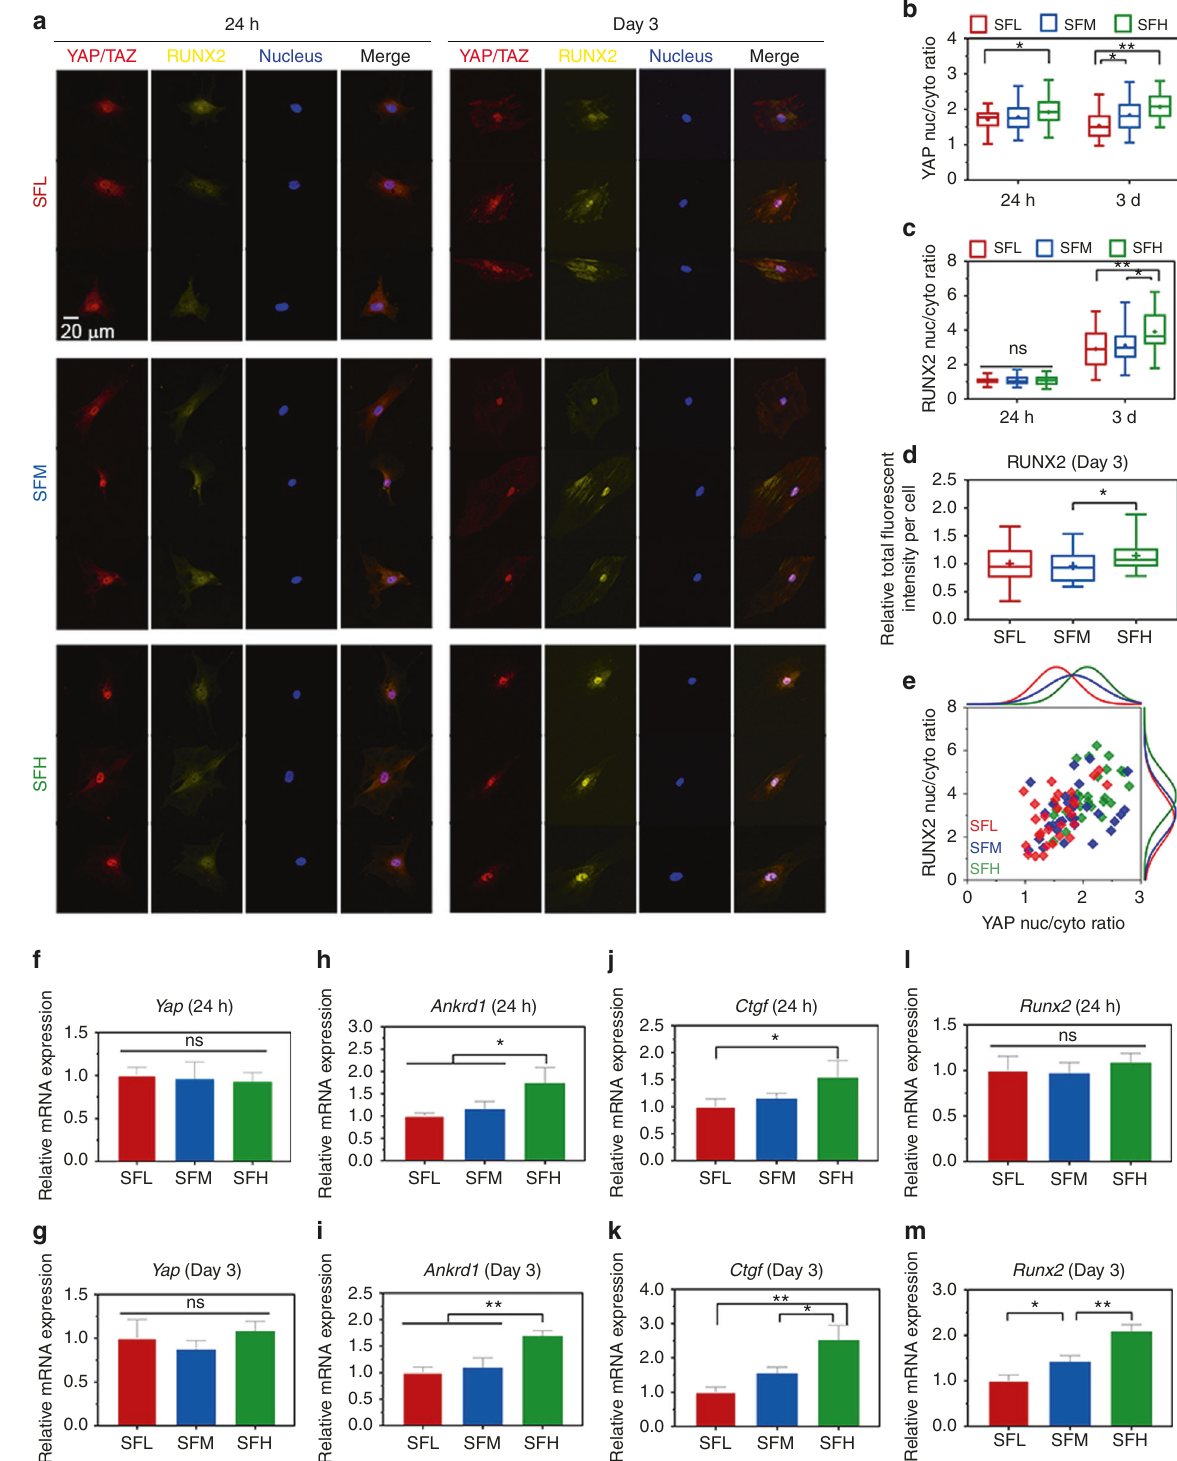
Fig. 5 YAP/TAZ and RUNX2 nuclear translocation in BMSCs on different SF substrates. a Representative mosaic immuno fl uorescence images of YAP/TAZ (red), RUNX2 (yellow), and nuclei (blue) in BMSCs at 24 h and day 3. b, c The nuclear-cytoplasmic ratios of ( b ) YAP/TAZ and ( c ) RUNX2 in BMSCs analyzed from the immuno fl uorescence images. d Relative fl uorescence intensity per cell of RUNX2 at day 3. e Single-cell scatter plots of the YAP/TAZ nuclei/cytoplasm ratio as a function of the RUNX2 nuclei/cytoplasm ratio at day 3. f – m The mRNA expression levels of ( f – g ) Yap , ( h – i ) Ankrd1 , ( j – k ) Ctgf , and ( l – m ) Runx2 in BMSCs at 24 h and day 3. For each box plot, the box boundaries represent the 25th – 75th percentiles, and the whiskers represent the min and max values. The central line and cross represent the median value and mean, respectively. Error bars represent one standard deviation. (* P < 0.05 and ** P <